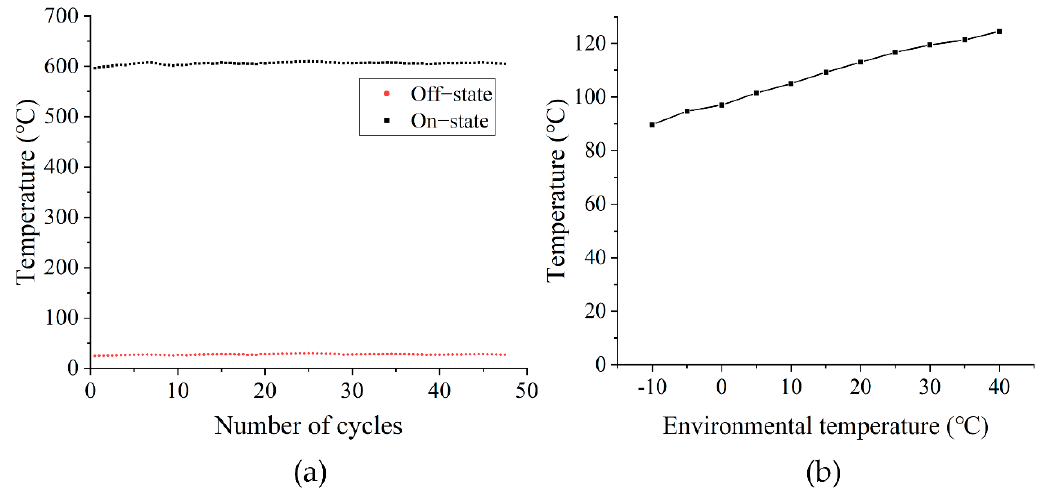
Figure 12. ( a ) Long term on/off cycling test on the fabricated devices. ( b ) The effect of environmental temperature changes on the micro-hot plate.